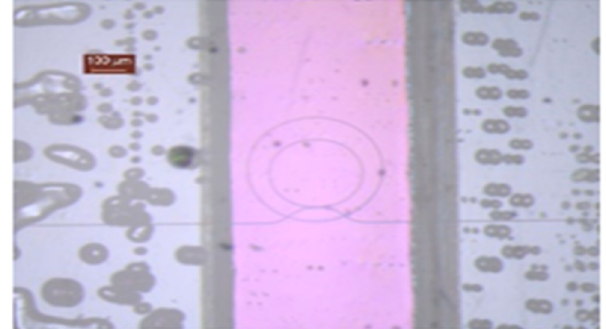
Figure 6. Fluidics detail and interconnection holder.